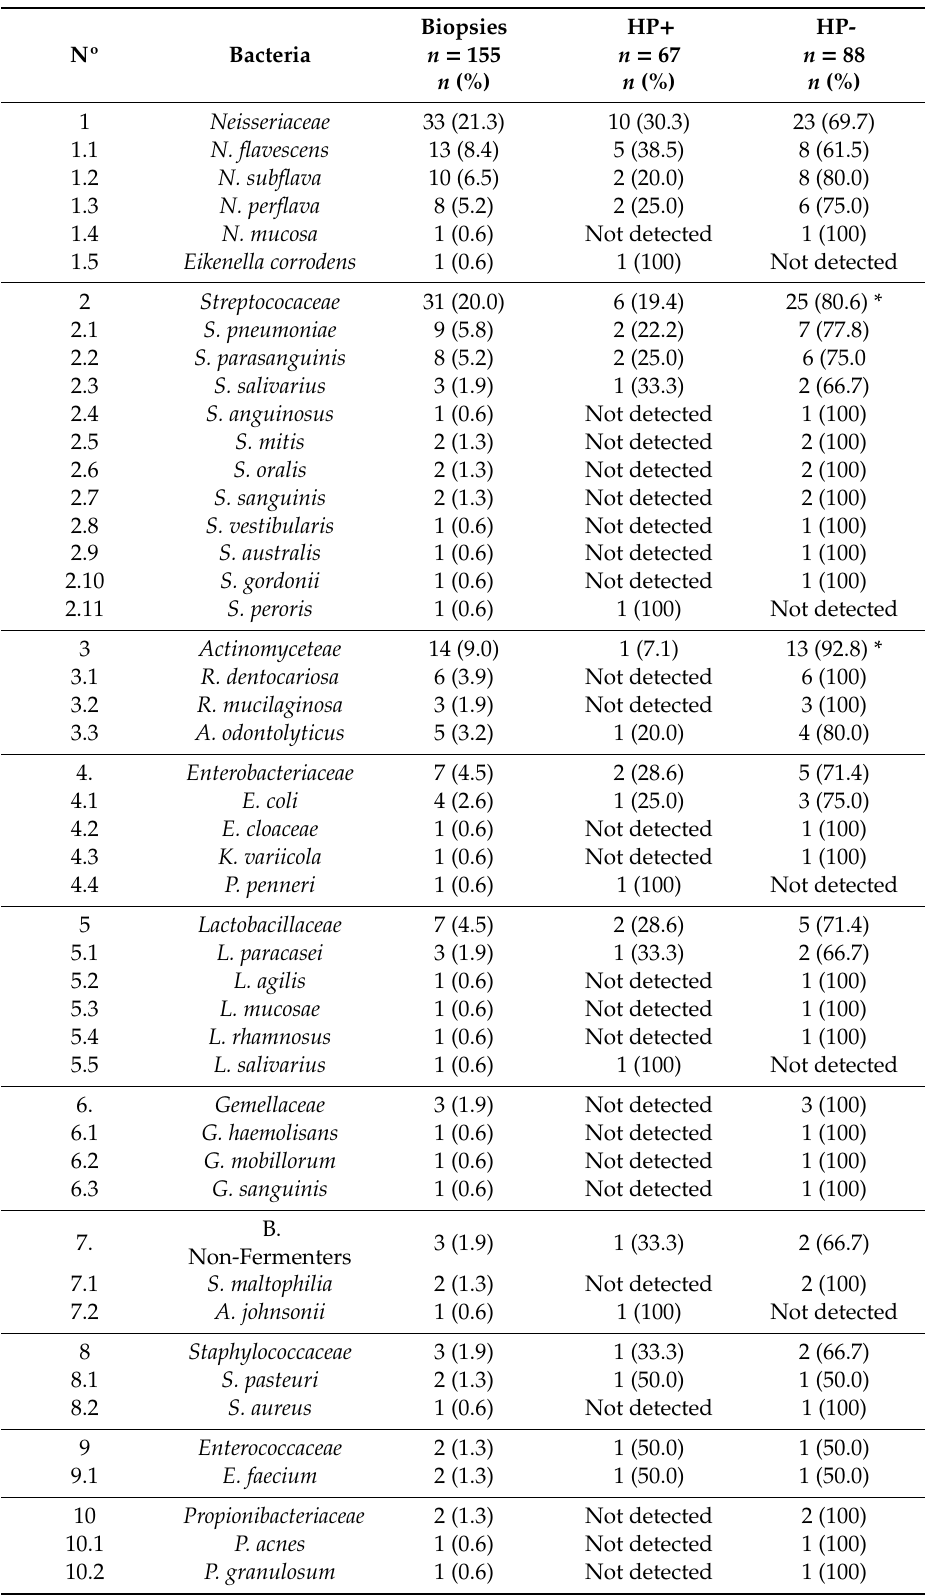
Table 3. Culturable bacteria isolated from gastric tissue colonized (HP + ) and non-colonized (HP-) by Helicobacter pylori